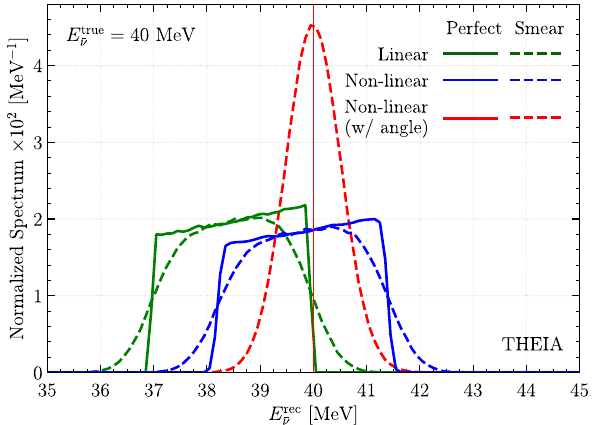
Fig. 2 The reconstructed neutrino energy E rec ¯ ν spectrum of IBD events = 40MeV with linear at the THEIA detector for a true energy E true ¯ ν e (green) and non-linear reconstruction methods with (red) or without (blue) angular information. For comparison, both results with (dashed) and without (solid) energy smearing are